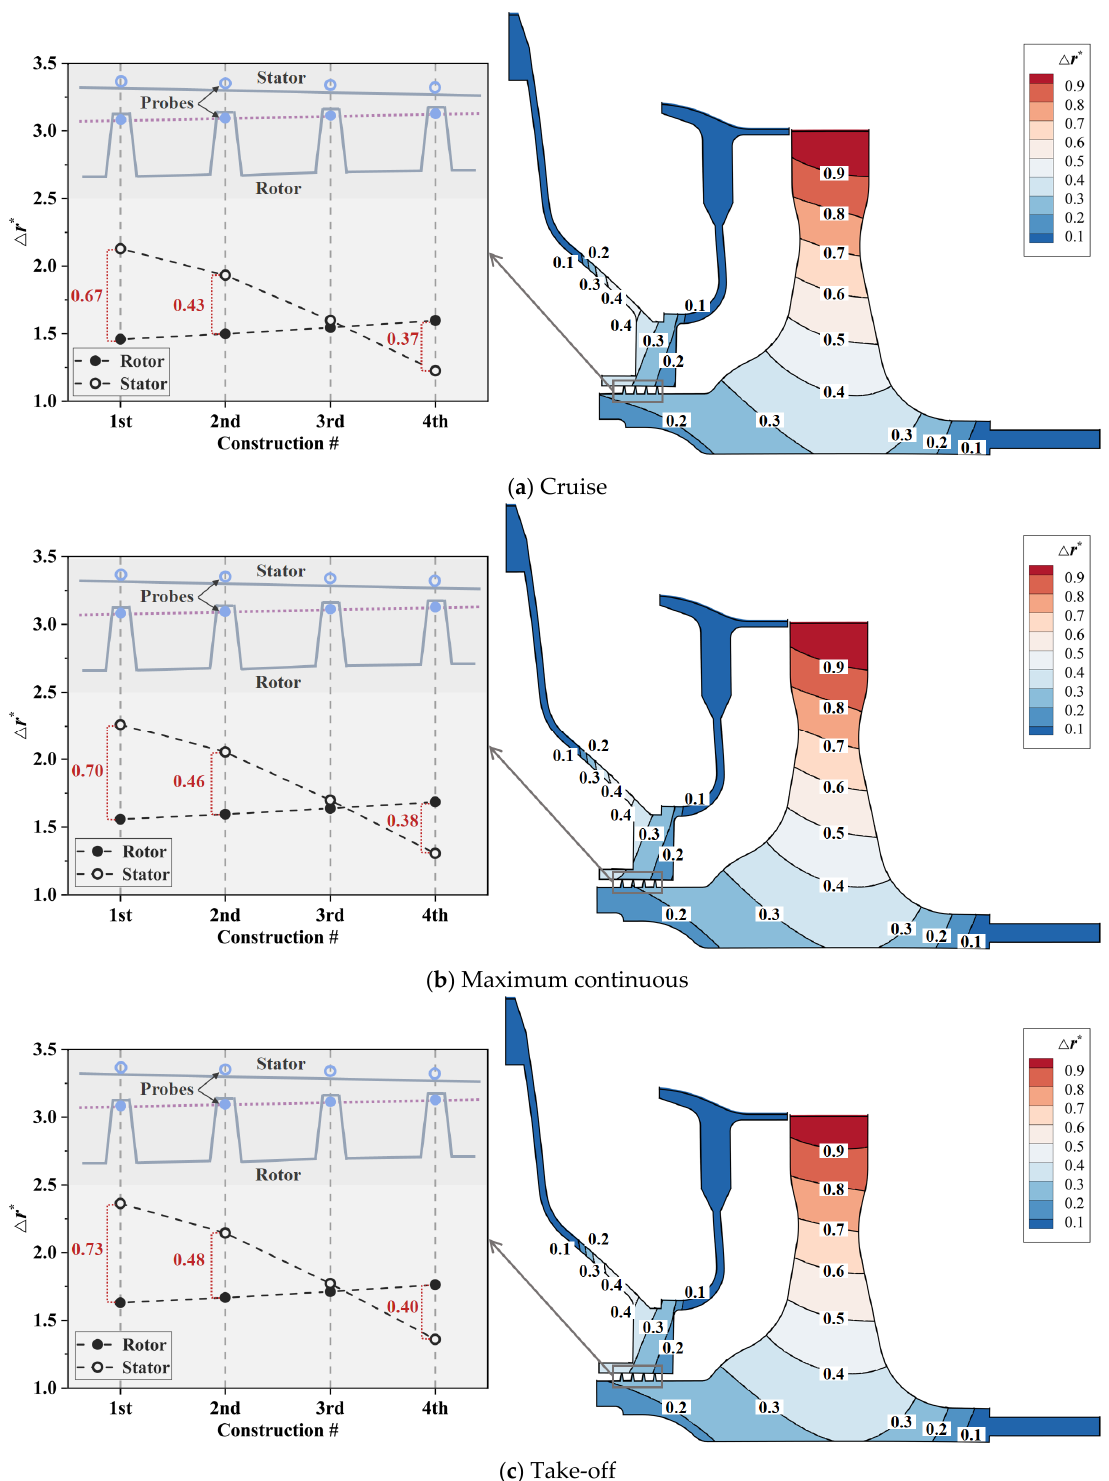
Figure 12. Distributions of dimensionless radial deformation.